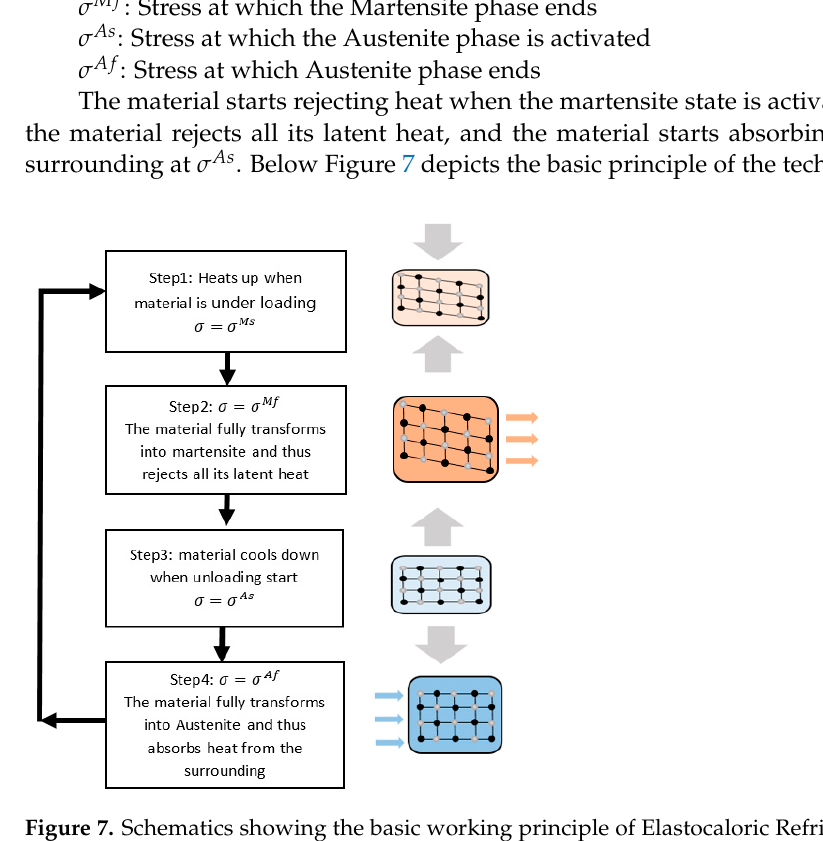
Figure 7. Schematics showing the basic working principle of Elastocaloric Refrigeration based on information obtained from Shape Memory Alloys by Lagoudas [51].